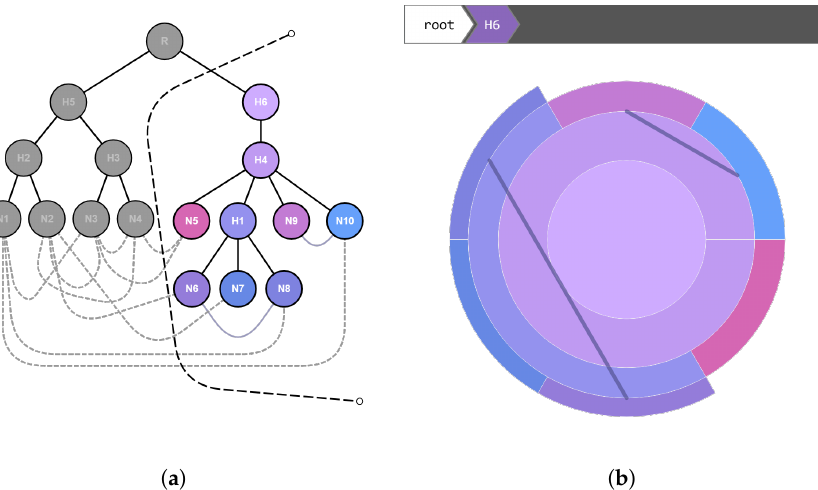
Figure 4. Hierarchy pruning by selecting a branch: ( a ) Focusing on H6 node discards all other branches and turns H6 into the root of the depicted tree. ( b ) The breadcrumb trail provides a reference to the hidden ancestors of the selected node.